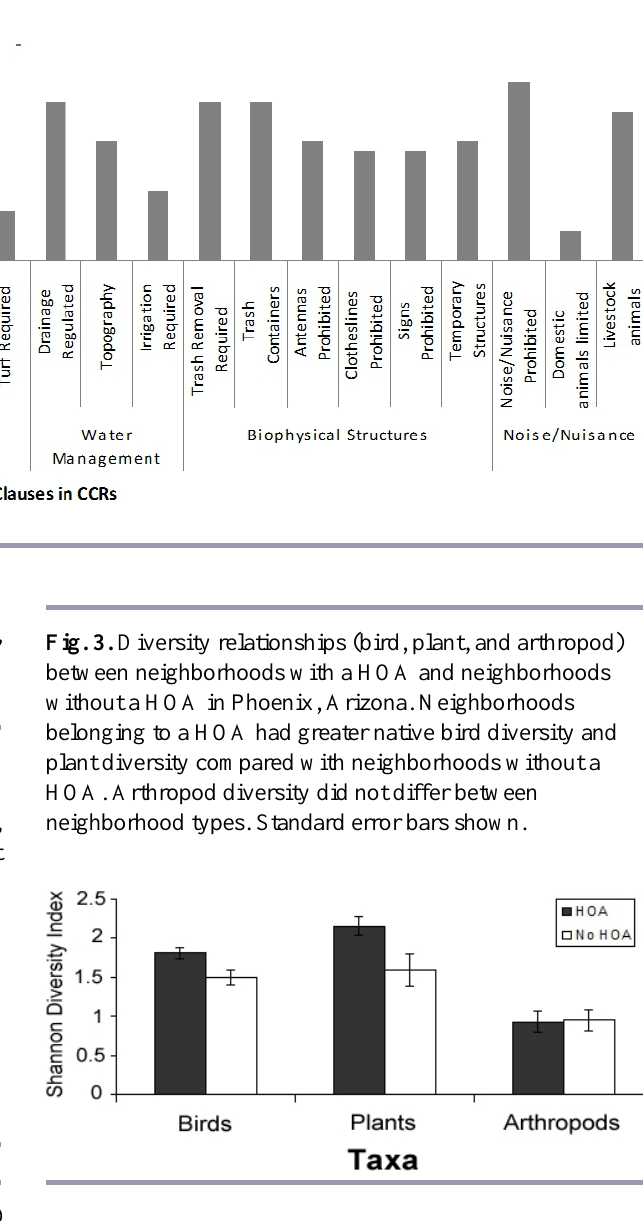
Fig. 2. Covenants, conditions, and restrictions (CCR) for landscaping practices in HOA neighborhoods, Phoenix, Arizona.